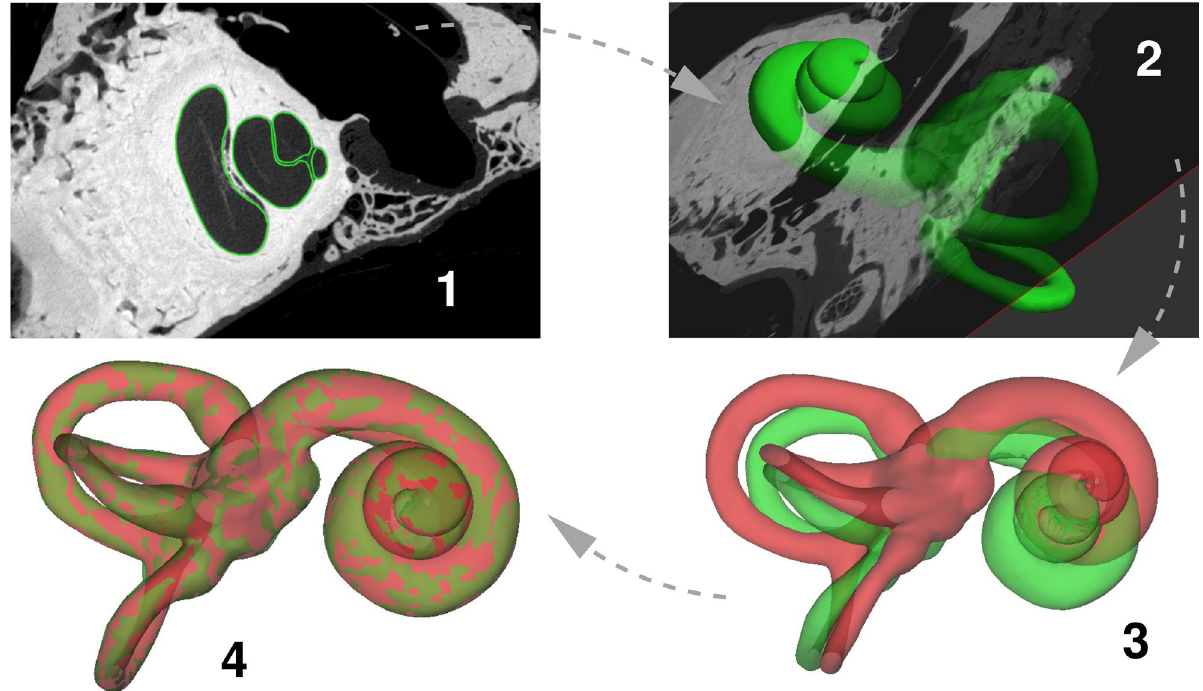
Figure 1. Constructing otic capsule models. (1) The micro-CT scans were segmented in Stradview by simple thresholding followed by manual tidying up of the contours. (2) Stradview was then used to construct triangulated surface meshes of each specimen. (3) Since each mesh has a different number of triangles and vertices, the next step is to align a common template mesh (red) with each specimen (green). This allows statistical analysis of the deformation at each of the template’s vertices, and subsequent construction of an SSM. (4) The alignment involves translation, rotation, isotropic scaling and (if necessary) reflection, followed by a nonrigid thin-plate spline deformation. The deformation was computed in wxRegSurf using the sliding semilandmark